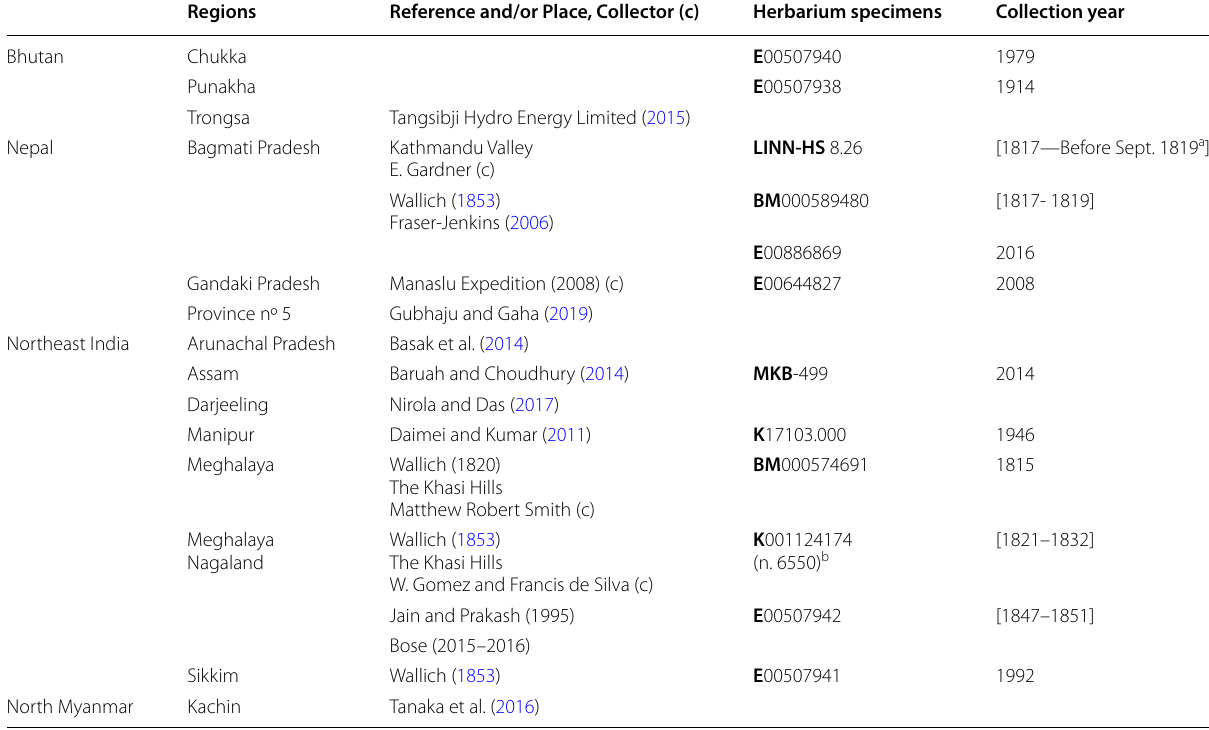
Table 3 Native distribution of Hedychium